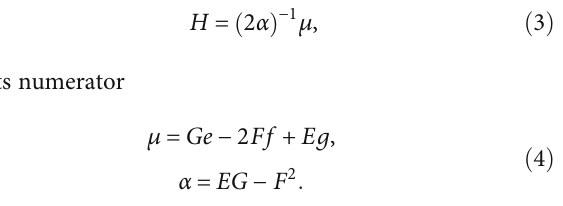
Table 1: Summary of results for three surfaces x ð u , v Þ , namely, Coons patch, Bilinearly blended patch, bicubically blended Coons patch (BBCP), Ferguson surface, and Hump-like surface with initial surface areas written in the fi rst column. A are the percentage decrease in areas. The last column reports the optimal value t min of our variational parameter t . p ij Hump-like surface, Coons patch, bilinear interpolation, BBCP, Ferguson surface x u , v